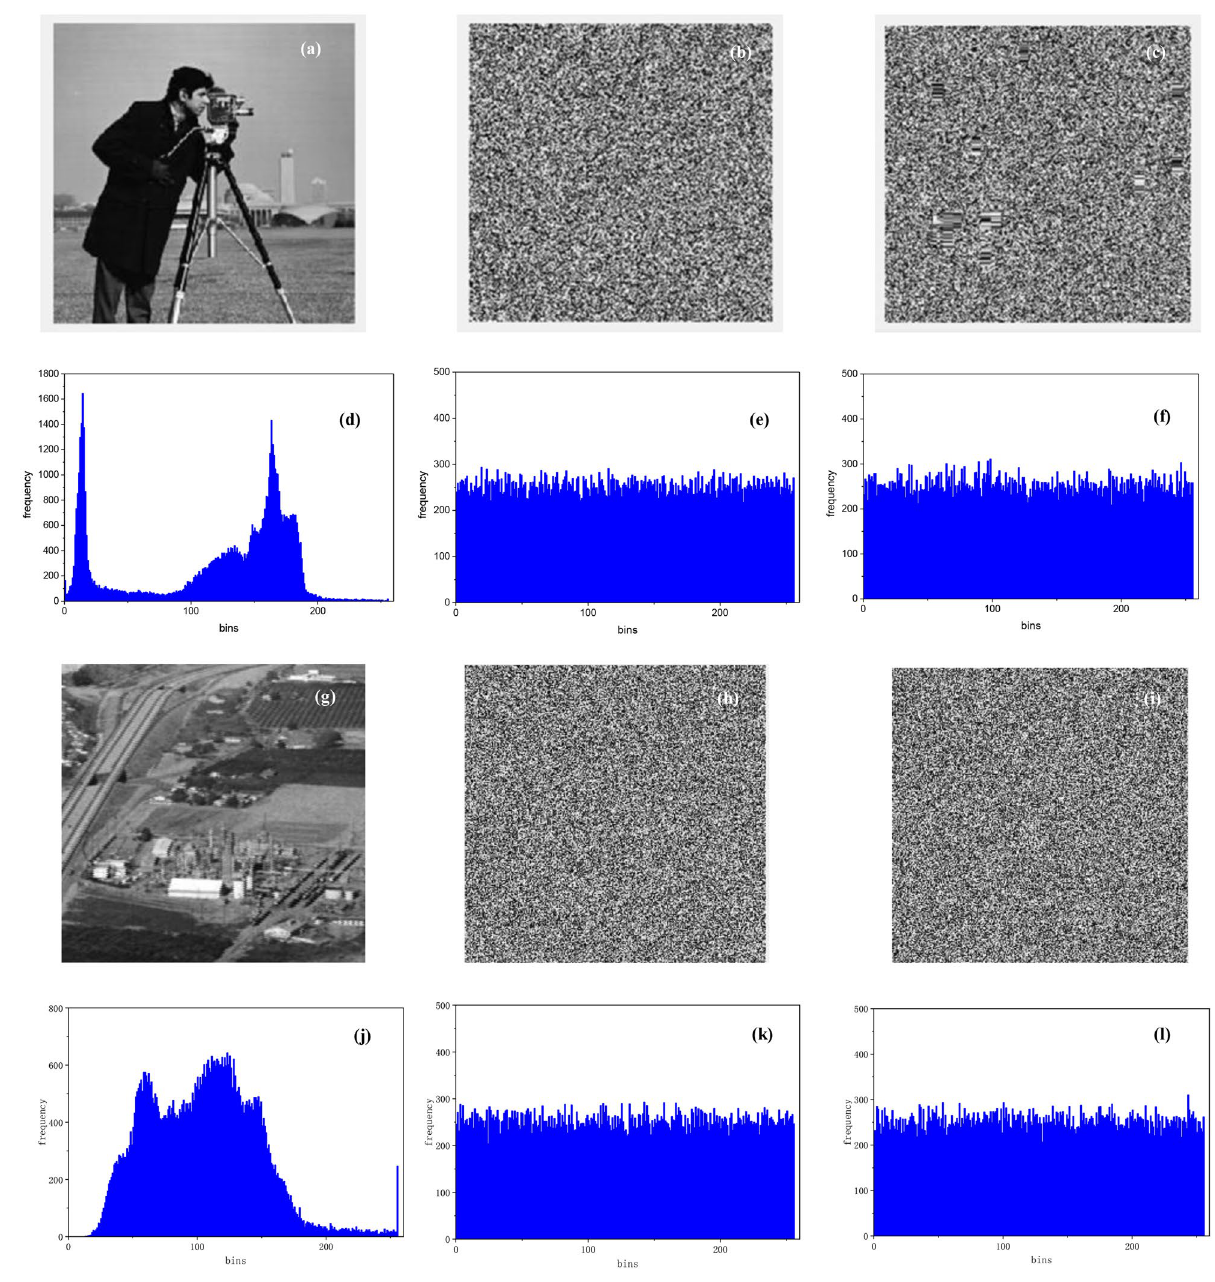
Figure 4. Histograms of the image encryption. ( a - f ) Cameraman: ( a ) original image; the image after ( b ) proposed encryption, ( c ) conventional AES; histogram of the ( d ) original image, ( e ) encrypted by proposed algorithm, ( f ) encrypted by conventional AES; ( g - l ) Chemical plant: ( g ) original image; the image after ( h ) proposed encryption, ( i ) conventional AES; histogram of the ( j ) original image, ( k ) encrypted by proposed algorithm, ( l ) encrypted by conventional AES.